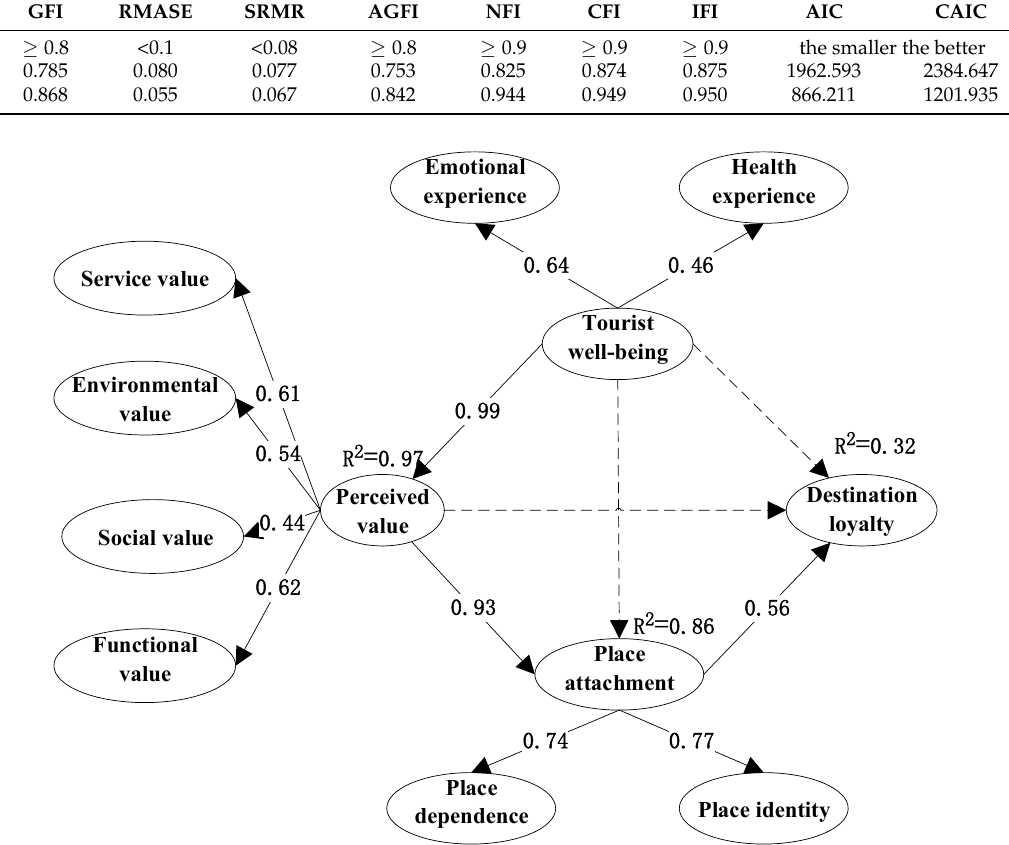
Figure 2. The estimated structural model (cid:2870) for the LA. Table 6. Validation analysis results of model (cid:2870) .